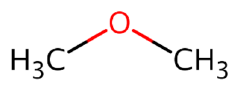
Figure 2. Structural formula of DME.